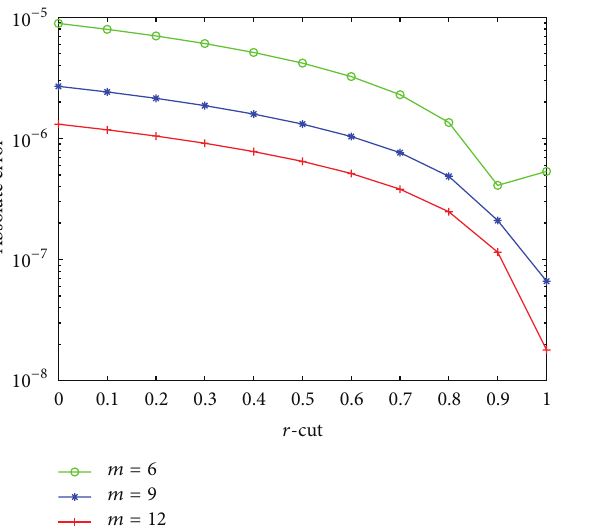
Figure 8: The absolute error for different 𝛼 of Example 57, 𝑚 = 8 .